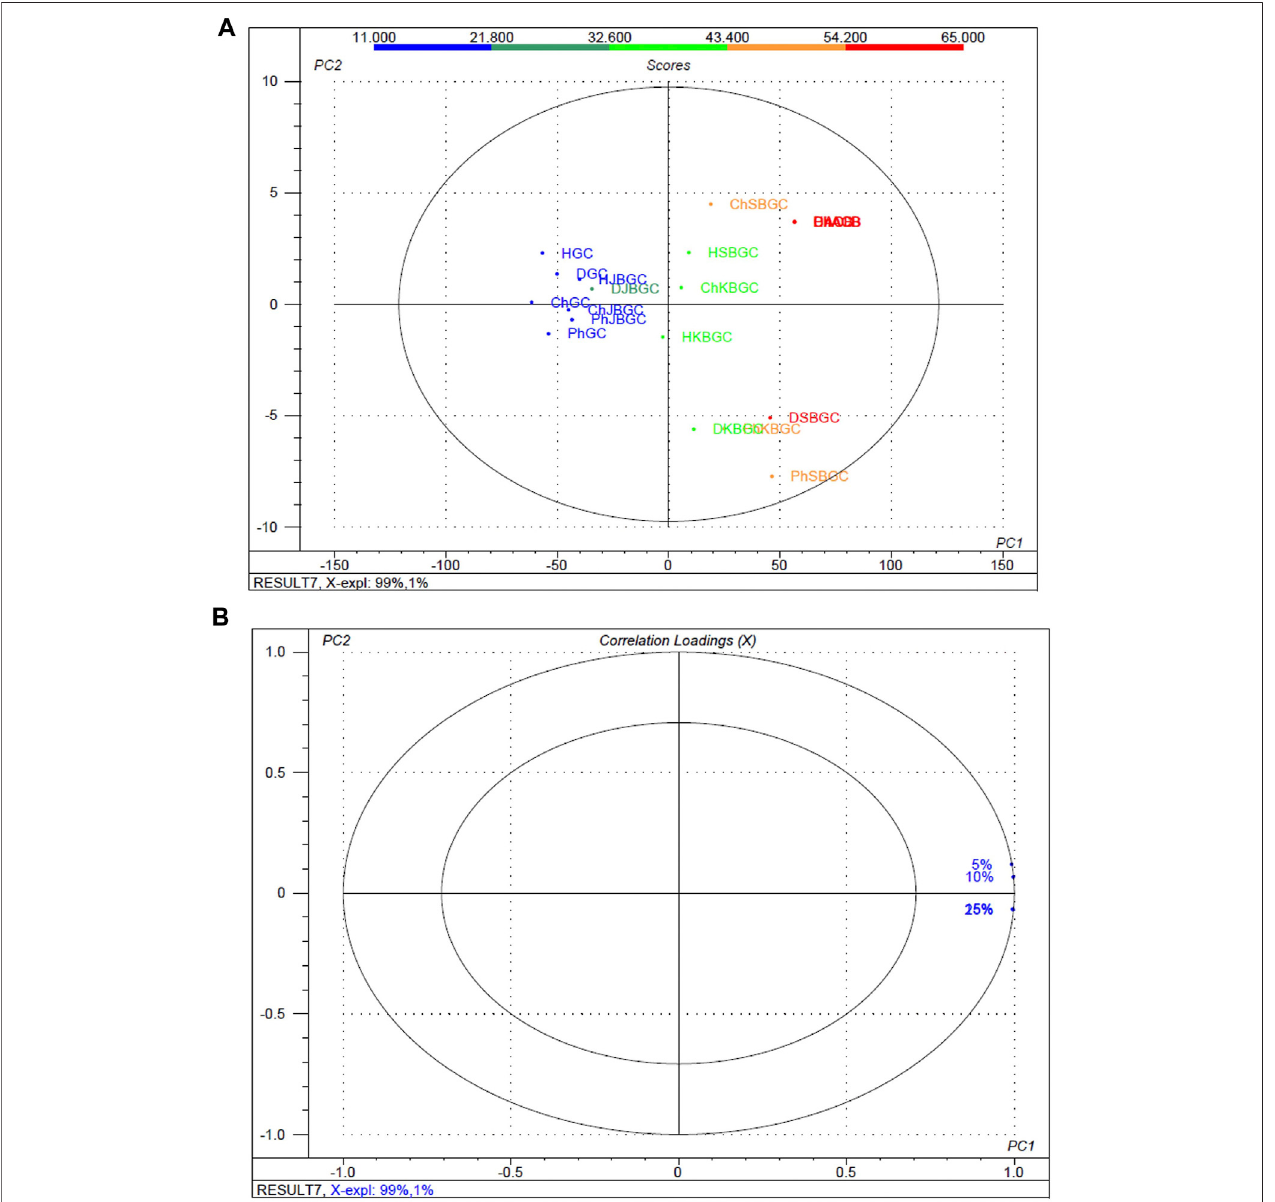
FIGURE 4 | Multivariate statistical analysis of codi fi ed different polarity Guduchi samples (Ph: phosphate buffer solution, D: dichloro methane, Ch: chloroform, and H: hexane) based on an unsupervized PCA model. (A) Unsupervized PCA score plot (B) Loading plot of α -amylase inhibitory activity of GC, JBGC, KBGC, SBGC formulations and various